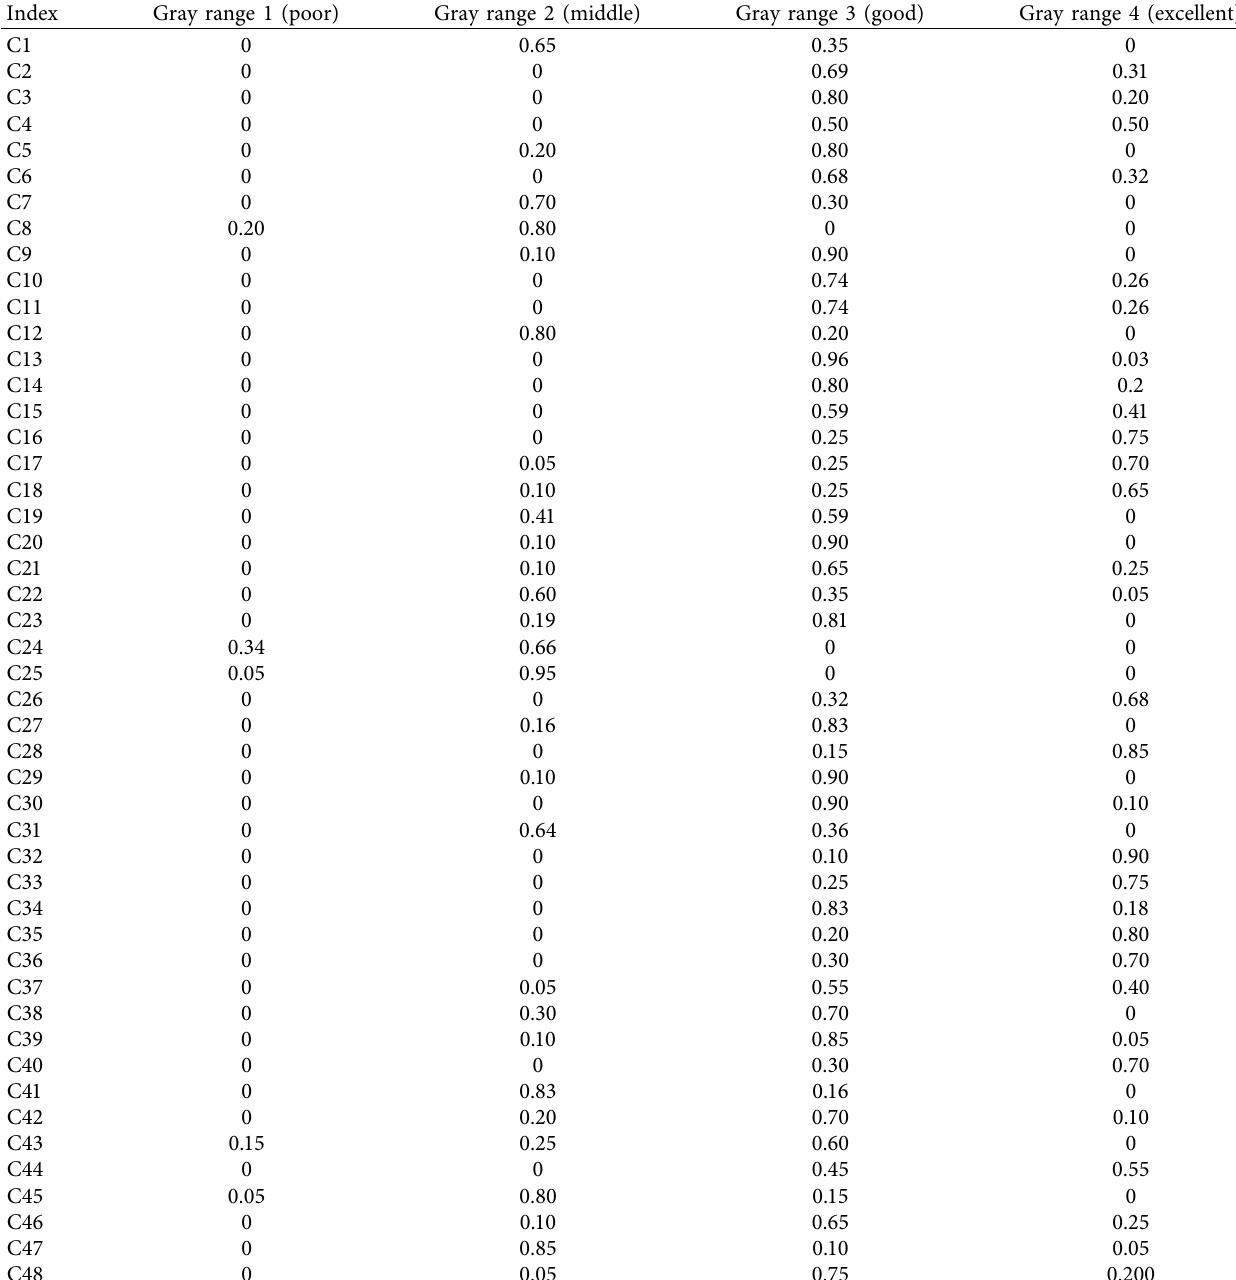
Table 5: Degree of the membership matrix for each